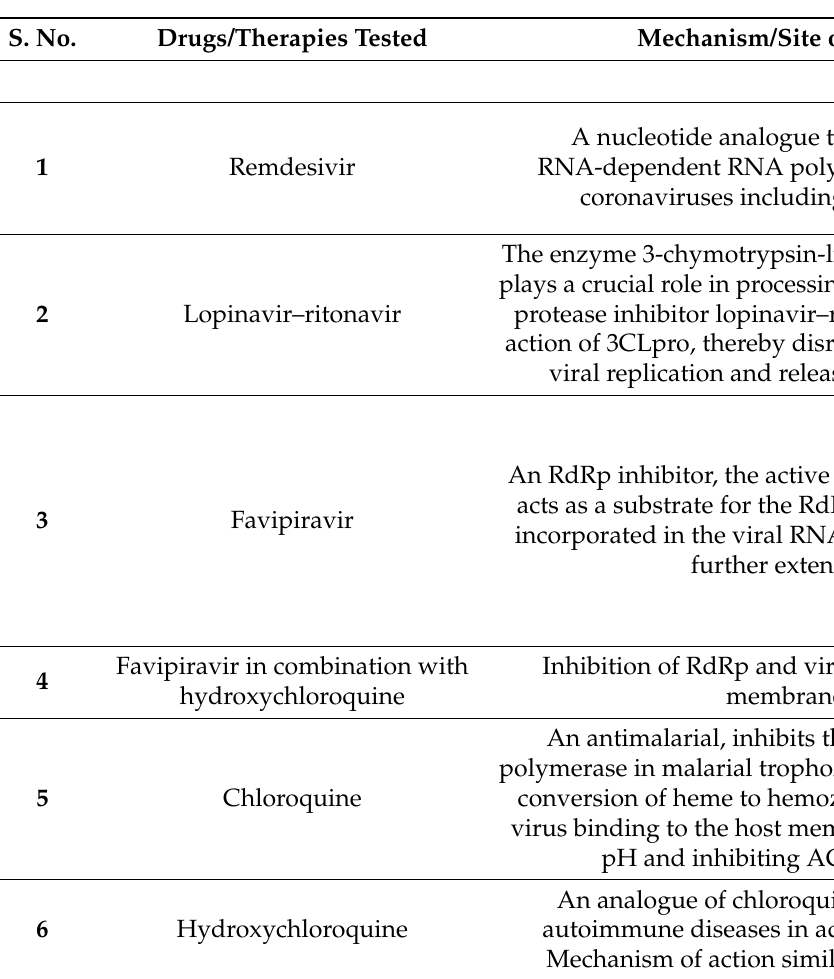
Table 1. Therapeutics tested against